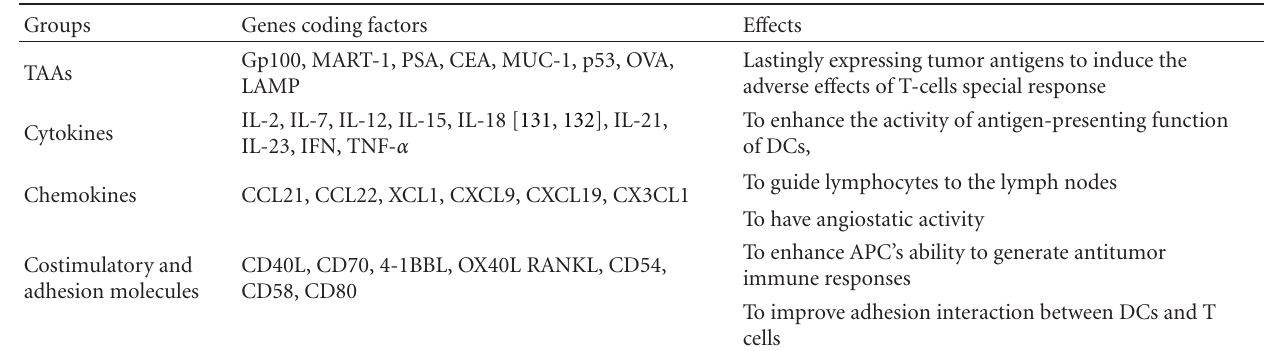
Table 2: Genes used for modification of